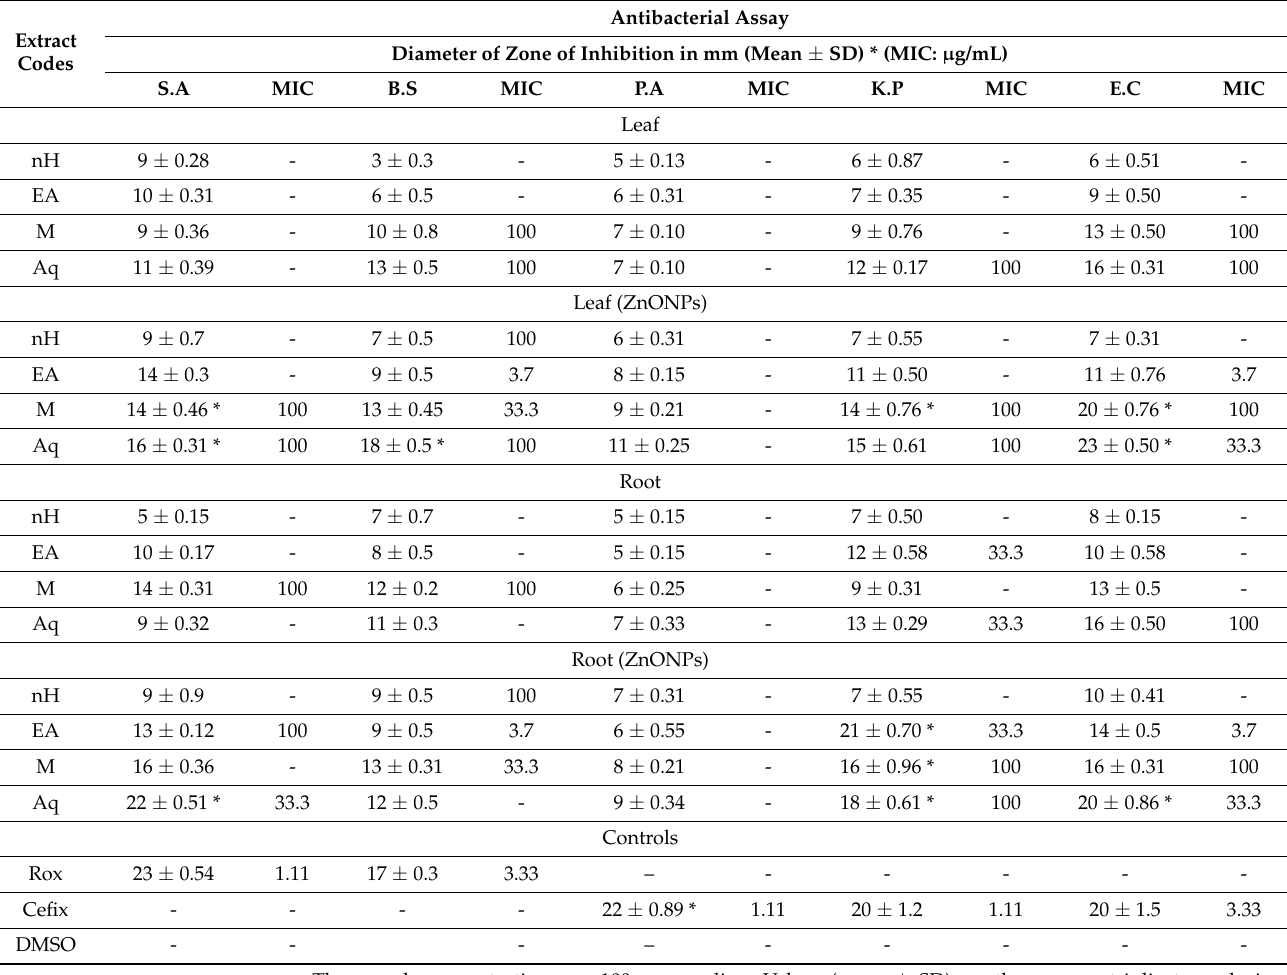
Table 2. Antibacterial activity and MIC values of W. somnifera crude extracts and